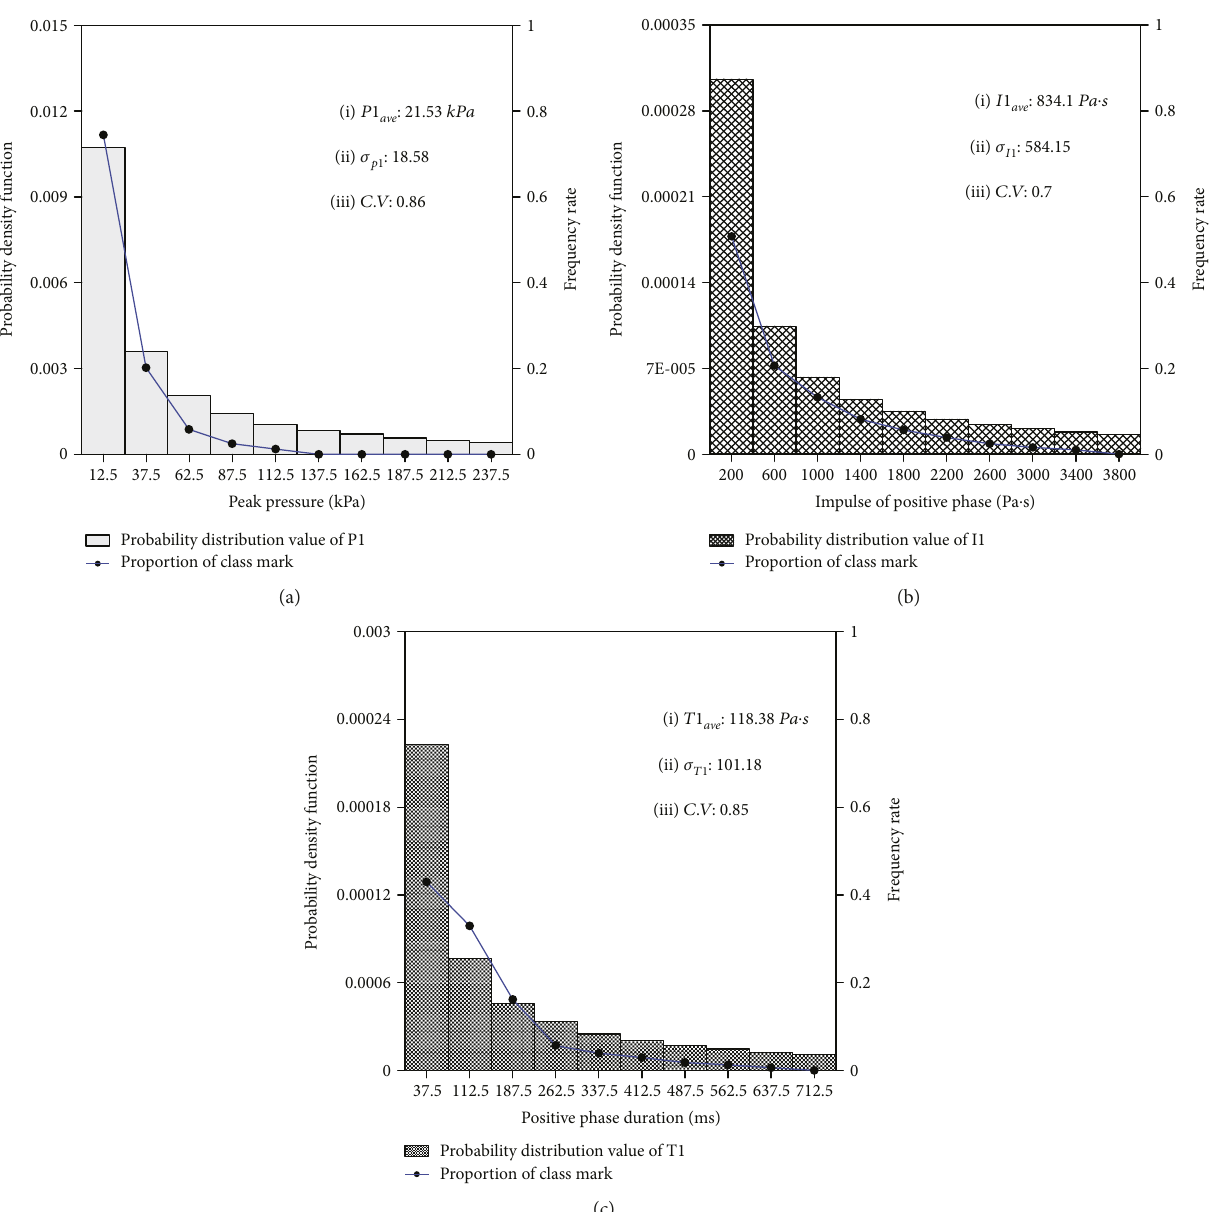
Figure 7: Probability density function for parameters in the positive pressure phase. (a) As for the peak pressure; (b) as for the impulse; (c) as for the duration